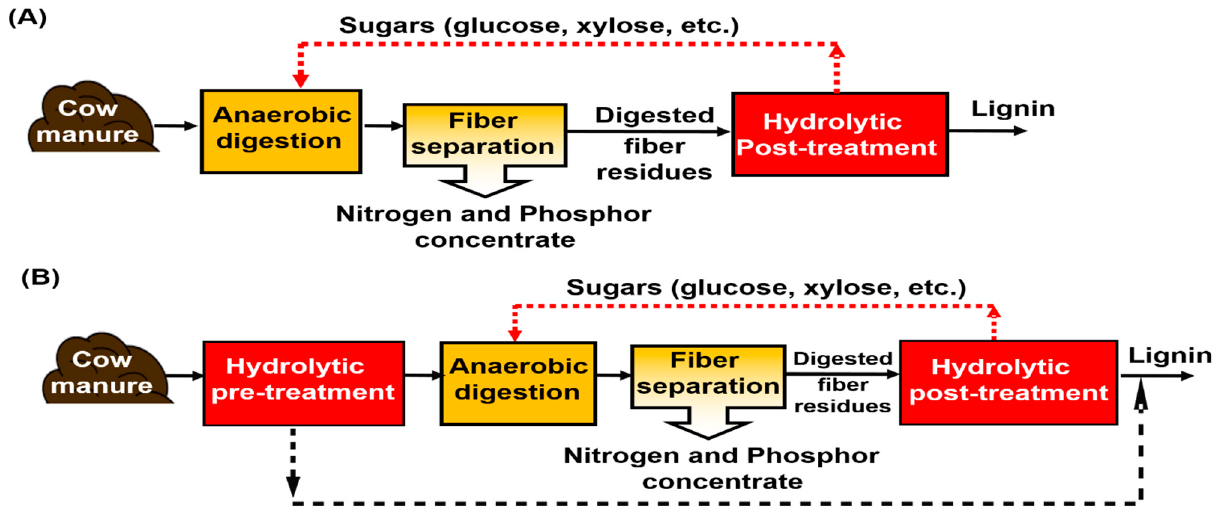
Figure 4. The proposed hydrolysis treatment configuration for manure energy recovery: ( A ) post-treatment and ( B ) pre- and post-treatment.